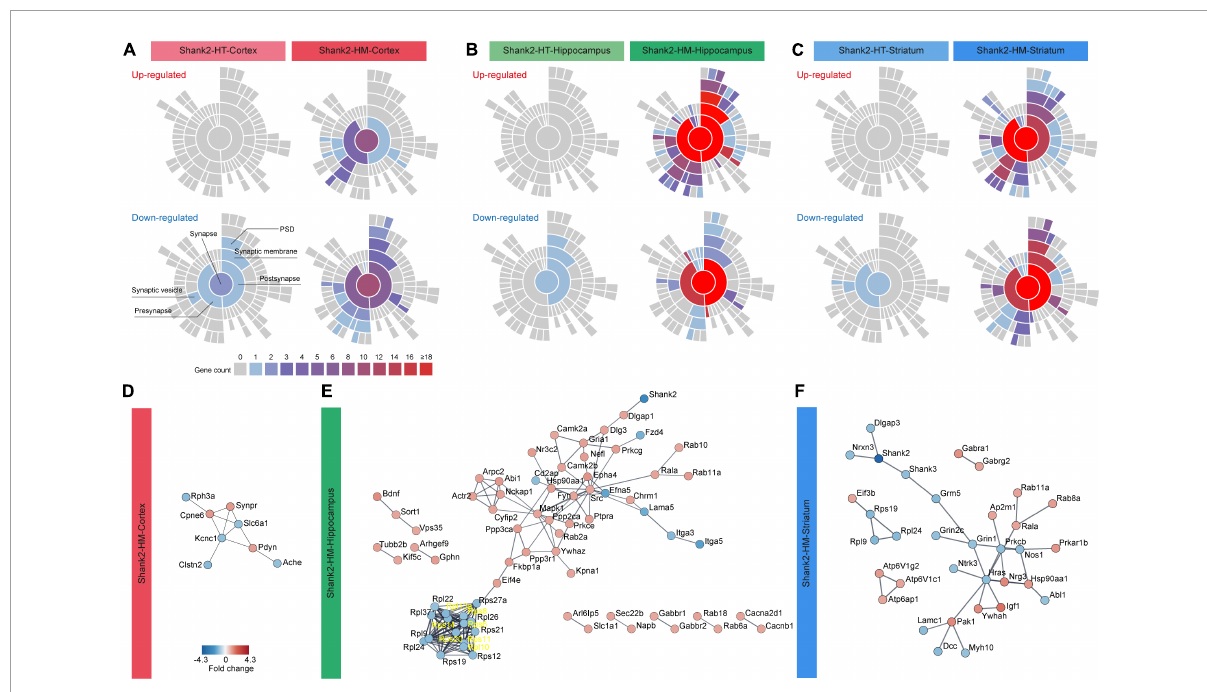
FIGURE3 Synaptic gene ontologies (SynGO) and protein-protein interaction (PPI) analyses of Shank2-heterozygous (HT) and Shank2-homozygous (HM) differentially expressed genes (DEGs). (A–C) Sunburst plot visualization of the SynGO results, highlighting the extents of pre/postsynaptic functions in the up/downregulated DEGs belonging to SynGO genes (SynGO-DEGs) of cortical, hippocampal, and striatal regions of Shank2-HT and Shank2-HM mice [13 weeks; male; n = 5 mice wild-type (WT), 5 (HT), and 5 (HM)]. (D–F) PPI analysis of cortical, hippocampal, and striatal Shank2-HM SynGO-DEGs. Differential cutoff values were used for different brain regions to increase the visibility of the PPI clusters [medium confidence (0.400) for HM-Cortex and high confidence (0.900) for HM-hippocampus and HM-striatum]. Red and blue colors indicate up and down fold changes,